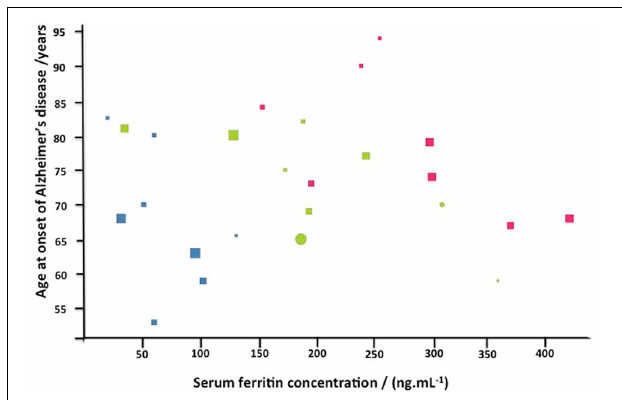
FIGURE 10 | Alzheimer’s disease as a function of serum ferritin for normal (blue) slightly (green) or strongly affected (red) morphologies. Also displayed are gender (females circles, males squares), and duration in years (via the size of the